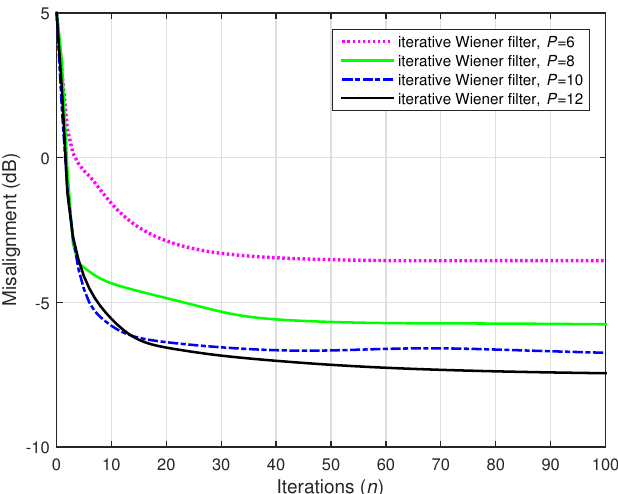
Figure 23. Performance of the iterative Wiener filter with different values of P , using N = 2000. The source signal (white Gaussian noise) was preprocessed with positive and negative half-wave rectifiers, using α = 0.3. The numbers of channels were M = 2 (stereophonic scenario), L = 1024, and SNR = 30 dB.